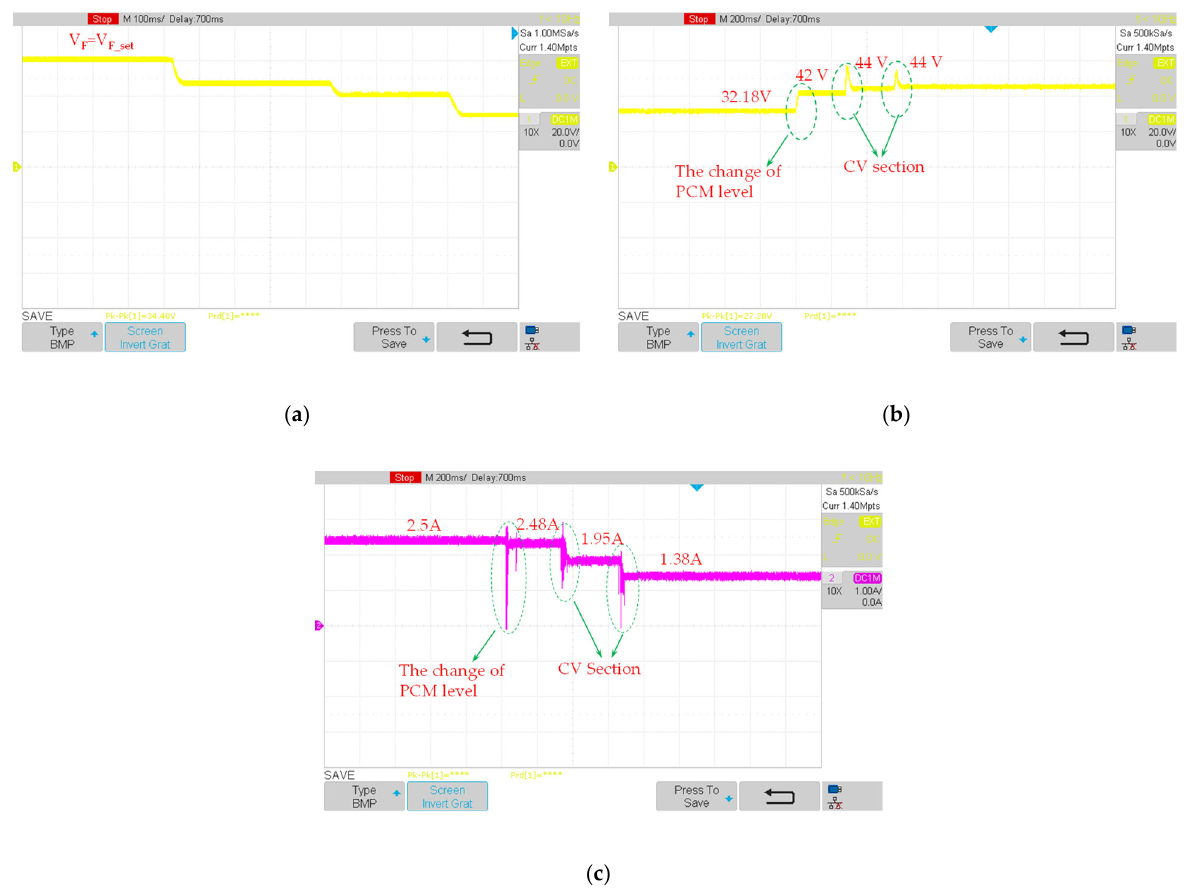
Figure 9. Experimental results of the control algorithm: the change of ( a ) V F ; ( b ) V O ; ( c ) I O .